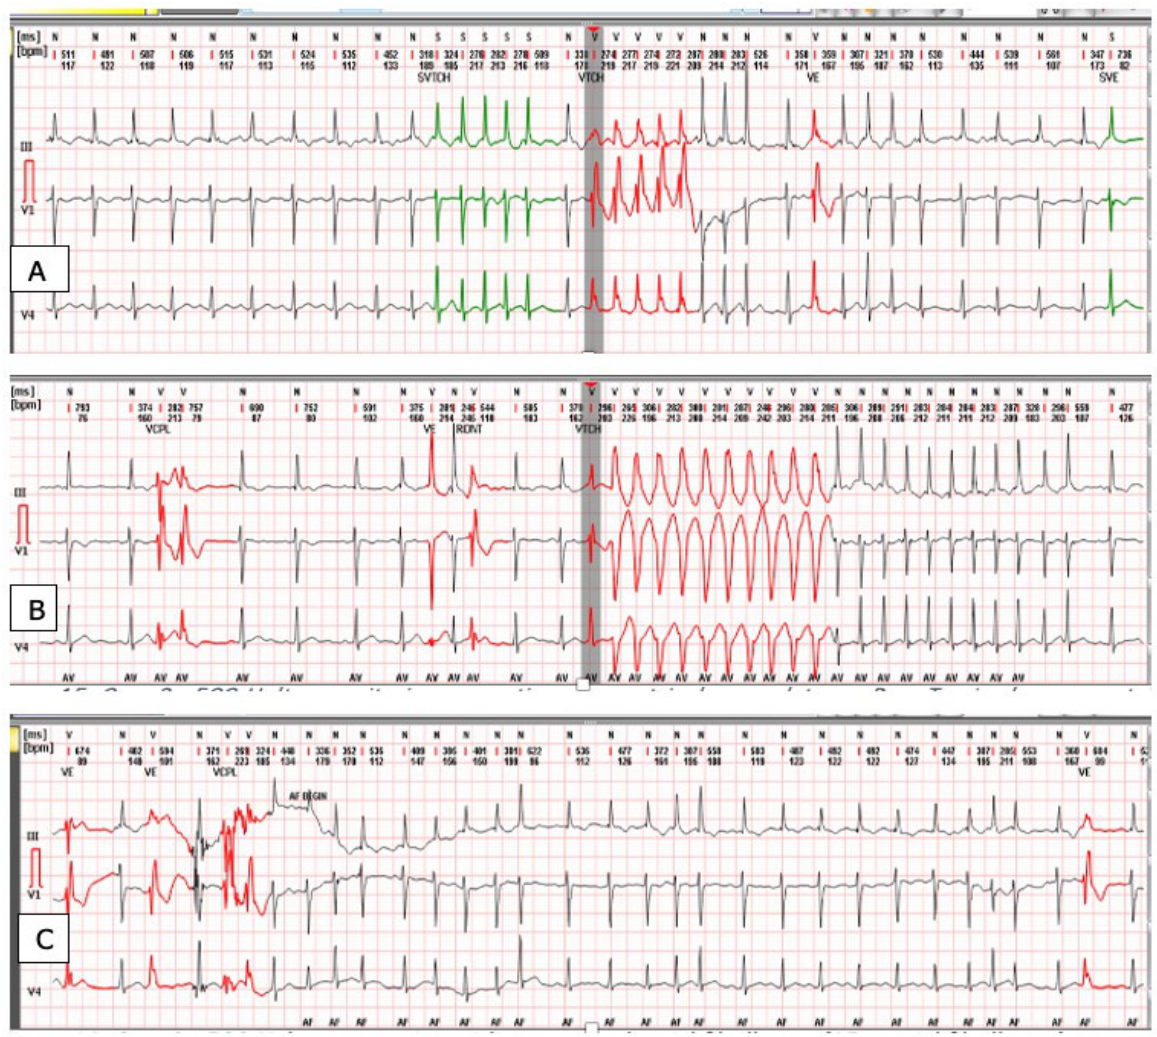
Figure 12. Case 3—( A ) ECG Holter monitoring shows an episode of supraventricular tachycardia and non-sustained ventricular tachycardia (SVTCH—supraventricular tachycardia, VTC—ventricular tachycardia). ( B ) ECG Holter monitoring presenting one ventricular couplet, one R on T episode, non-sustained ventricular tachycardia, and paroxysmal atrial fibrillation (VCPL—ventricular couplet, VE—ventricular premature contraction, RONT R on T phenomenon VTCH—ventricular tachycardia). ( C ) ECG Holter monitoring with paroxysmal atrial fibrillation (AF—atrial fibrillation).